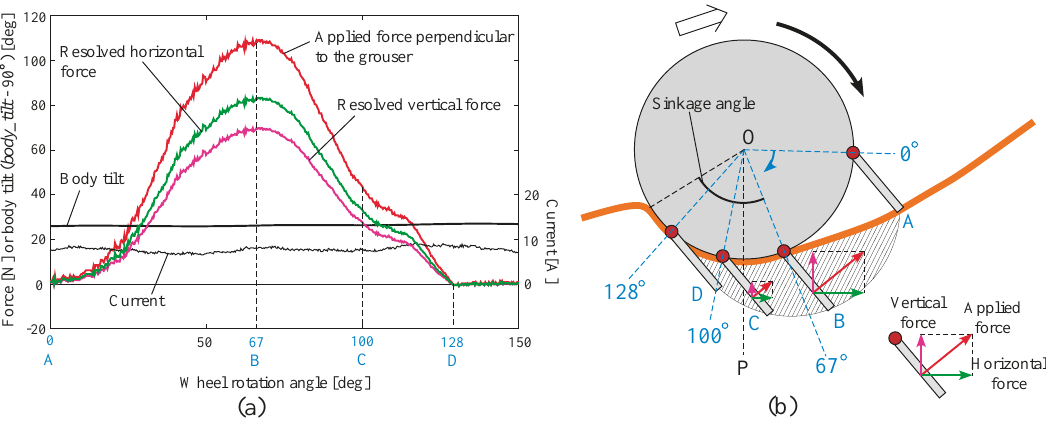
Figure 15. Results from the experiment to validate the effectiveness of assistive grousers on a sand incline of 30 degrees: ( a ) Sequential ordered graph of measured data; ( b ) Different states of a single assistive grouser as it moves under sand surface.